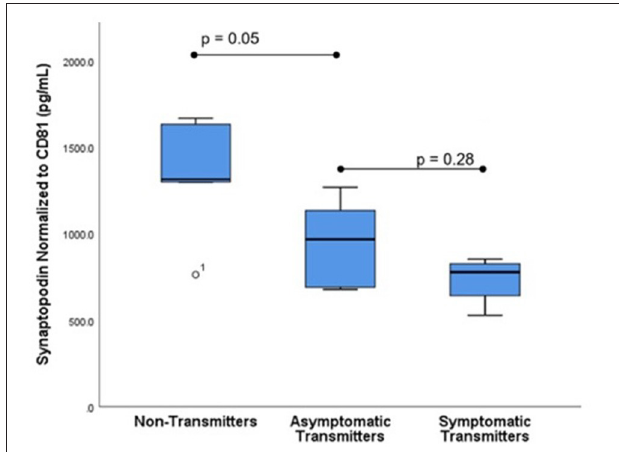
FIGURE 2 | Fetal CNS ECV synaptopodin levels by clinical outcome. ECV protein levels of synaptopodin normalized to CD-81 were compared in three groups: Non-transmitters (NT, n = 5), asymptomatic transmitters (AST, n = 5), and symptomatic transmitters (ST, n = 4). ANOVA testing was used to compare means. The p -value for significance was set at 0.05.